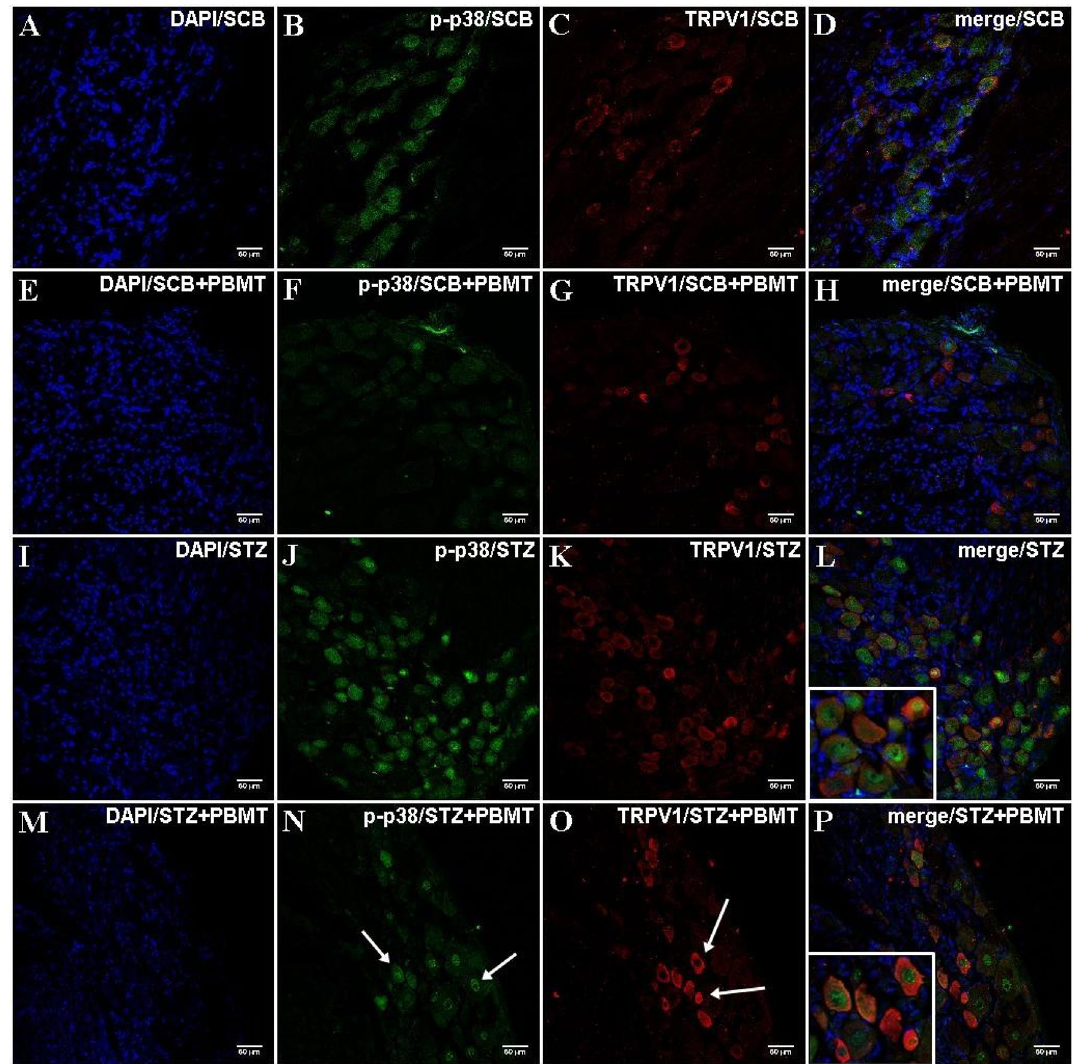
Figure 8. DRG histological micrographs of p-p38 MAPK and the co-staining of TRPV1 by confocal microscopy. DRG transversal sections were made in 14 µm thickness and submitted to IF protocol for staining endogenous p38 phosphorylation in Thr180 and Tyr182 ( B , F , J , N ) and TRPV1 ( C , G , K , O ). DAPI for nuclear staining is shown in ( A , E , I , M ). Merge (DAPI + p-p38 + TRPV1) images are also shown in ( D , H , L , P ). STZ + PBMT group showed moderate staining for p-p38 MAPK ( N ; white arrows) and increased staining for TRPV1 ( O ; white arrows). Details are shown in the left corner of ( L ) and ( P ). Magnification: ×40; scale bars: 50